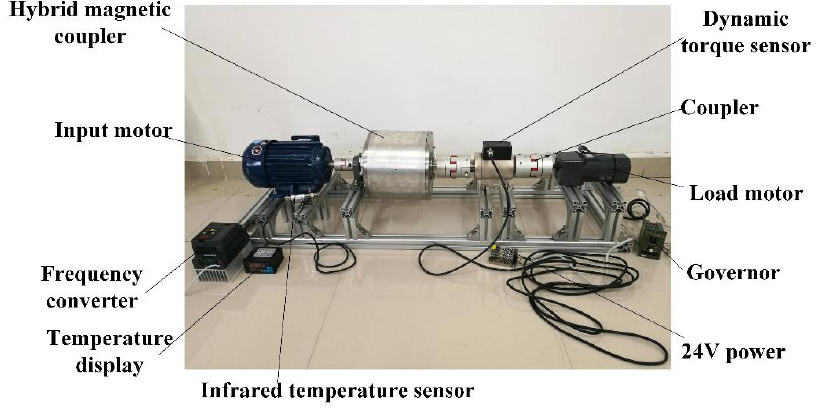
Figure 8. Test prototype diagram.